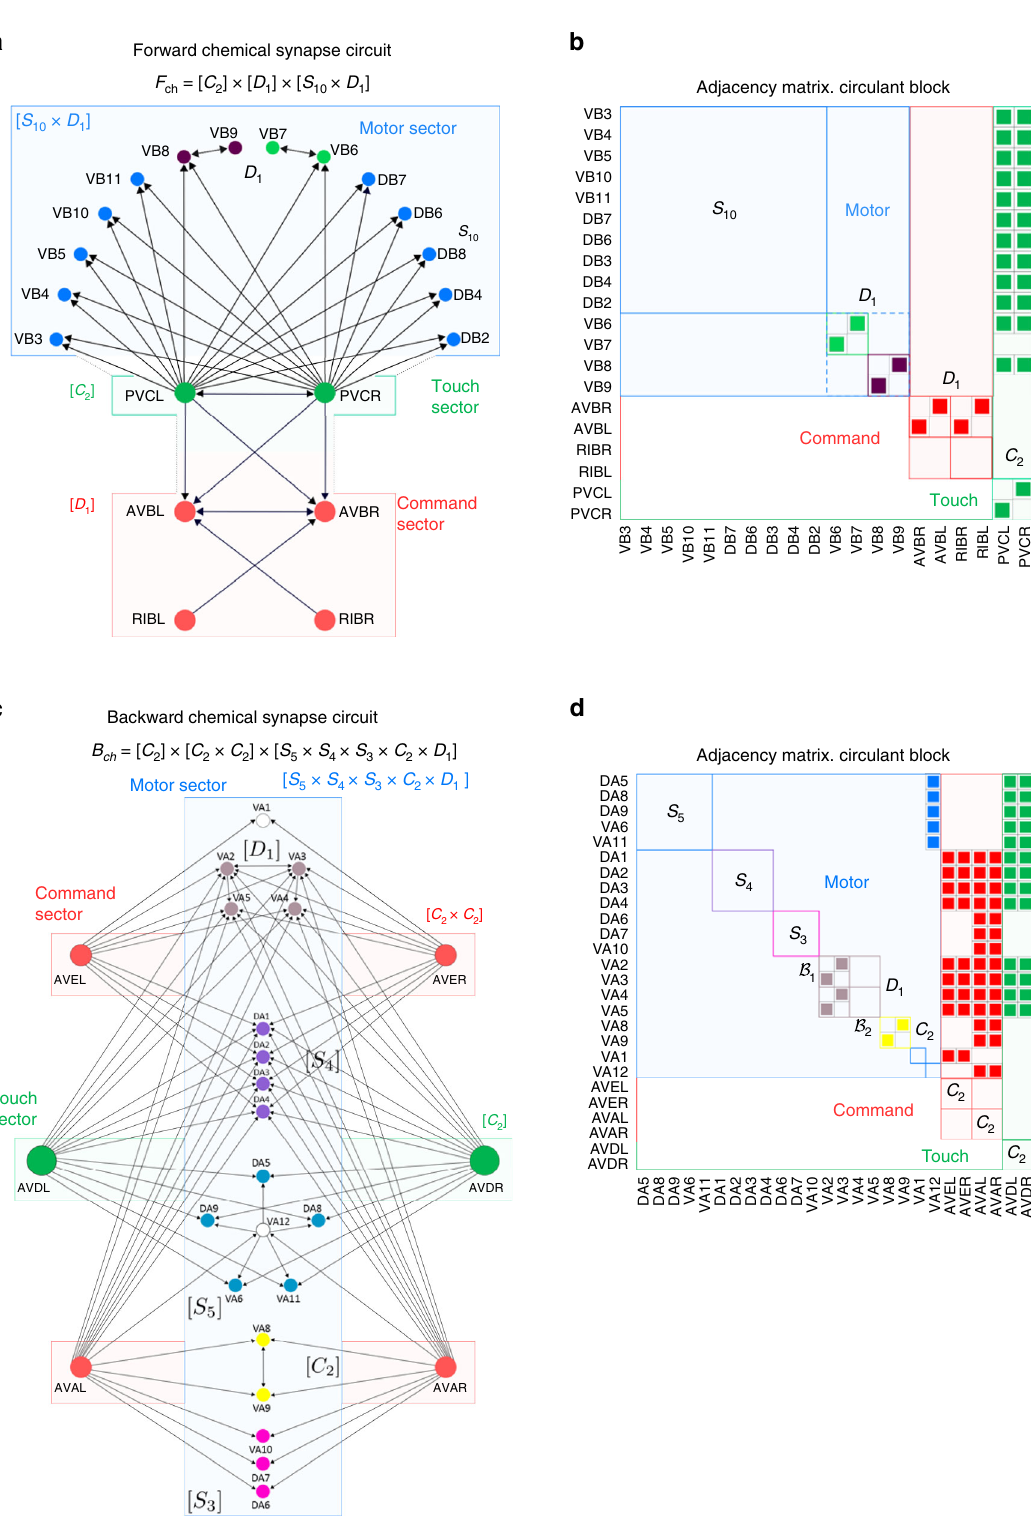
and B of the chemical synapse forward and backward circuits. a Forward locomotor chemical synapse circuit and ( b ) Fig. 4 Symmetry groups F ch ch is factorized into the direct product of its adjacency matrix (ideal circuits, real circuits in Supplementary Figs. 5 and 6). The symmetry group F ch ¼ C ´ ½ D (cid:3) ´ ½ S ´ D (cid:3) , which, in turn, split up the circuits into independent sectors of neurons command, motor, and touch subgroups as F ch 2 1 10 1 ¼ matching different functions and include also the neuron touch class PVC (forward) and AVD (backward). c The backward circuit factorizes as B ch C 2 ´ ½ C 2 ´ C 2 (cid:3) ´ ½ S 5 ´ S 4 ´ S 3 ´ D 1 ´ C 2 ´ C 2 (cid:3) : We show the ideal circuit and ( d ) its adjacency matrix. For simplicity we plot only the interneurons that connect to the motor neurons. Full circuit in SM Fig. 6. All neurotransmitters are cholinergic and excitatory (ACh) except for RIM which uses neurotransmitter Glutamate and Tyramine and AIB which is glutamatergic (see Supplementary Note 6). These different types of synaptic interactions respect the symmetries of the circuits, see Supplementary Note